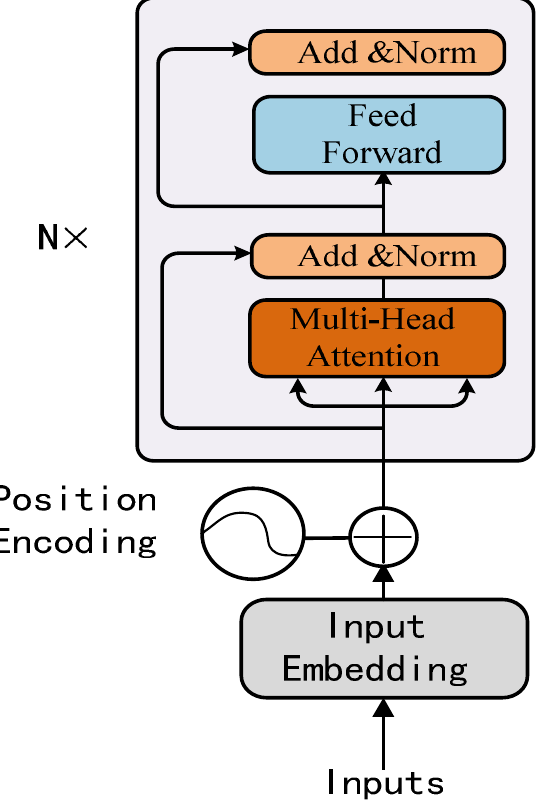
Figure 3. The structure of Transformer Encoder.